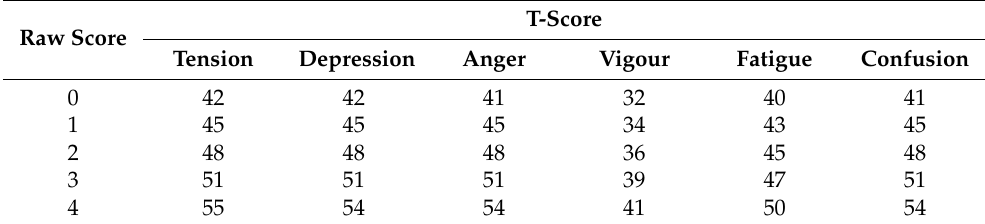
Table 4. MASMS normative scores for the whole sample ( n =